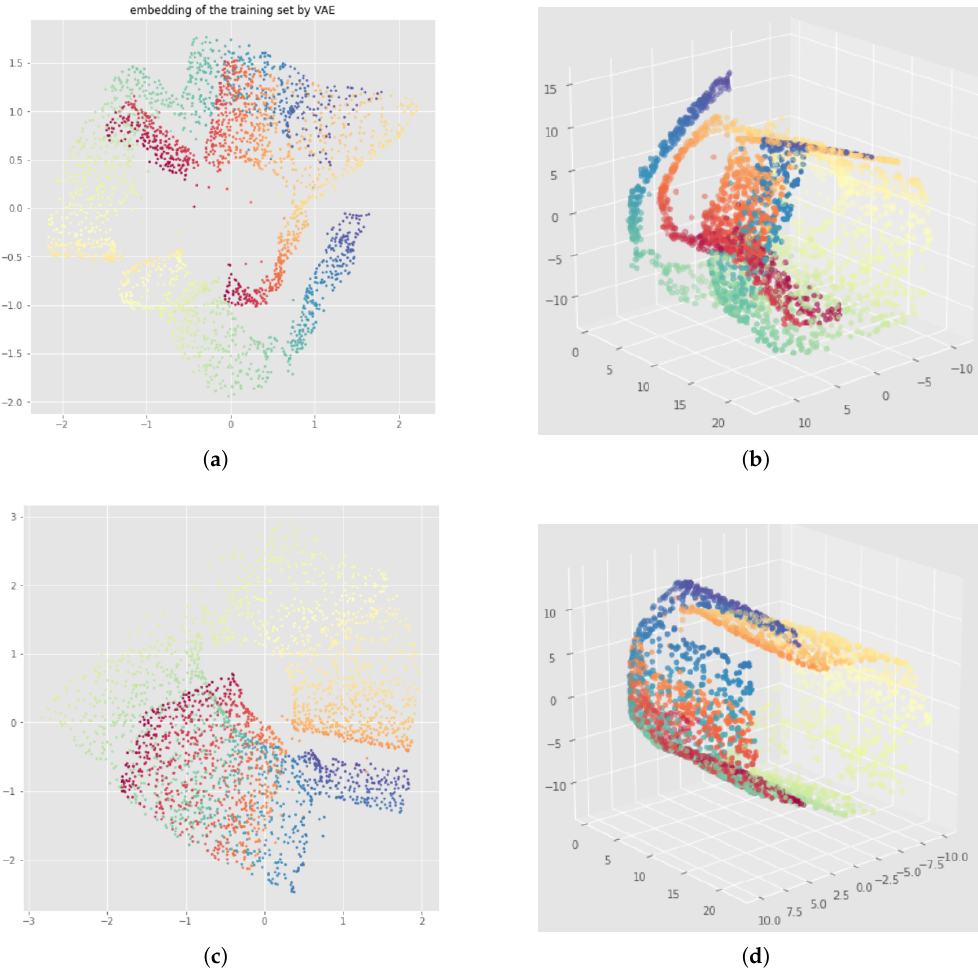
Figure 14. Latent representation (left) and corresponding reconstruction (right) of the Standard VAE applied to the swissroll for different initializations - pytorchseed = 3 (top) and pytorchseed = 4 (down), trained for 500 epochs. Again, discontinuities in the latent representation are transferred to the reconstructed swissroll. These representations are not useful for interpolating in the latent space. ( a ) Latent space (after 500 epochs) for a random initialization with pytorchseed = 3. ( b ) Reconstruction (after 500 epochs) for a random initialization with pytorchseed = 3. ( c ) Latent space (after 500 epochs) for another random initialization with pytorchseed = 4. ( d ) Reconstruction (after 500 epochs) for the other random initialization with pytorchseed =